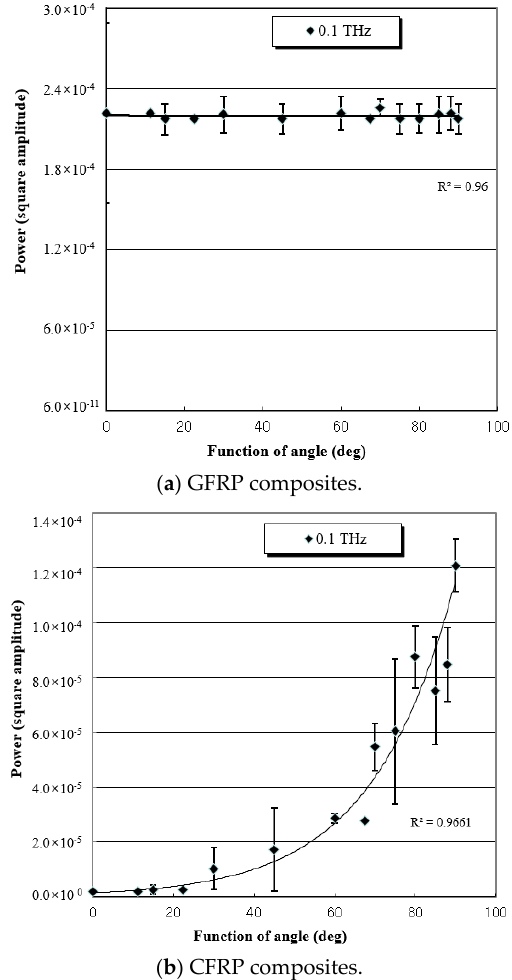
Figure 6. Amplitude profile of the penetrating power of both the GFRP and CFRP composites by the function of angle (a 24 − ply glass and carbon composites).